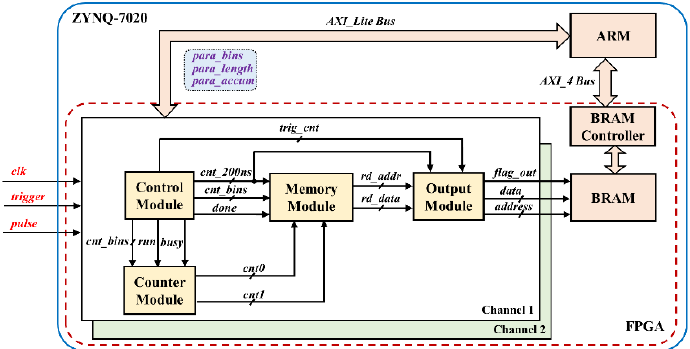
Figure 4. The Overall logical structure of the acquisition system.